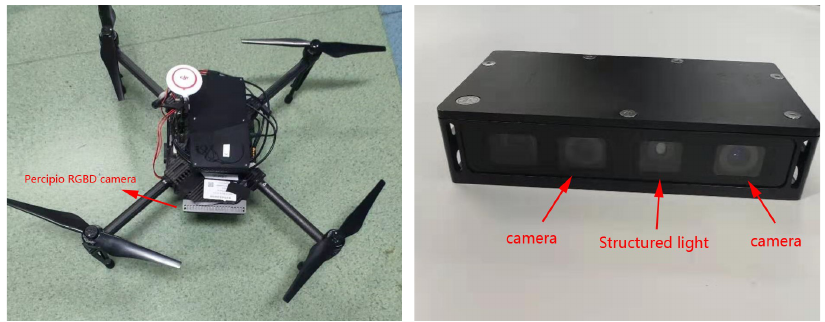
Figure 2. UAV ( left ), the Percipio RGB-D camera ( right